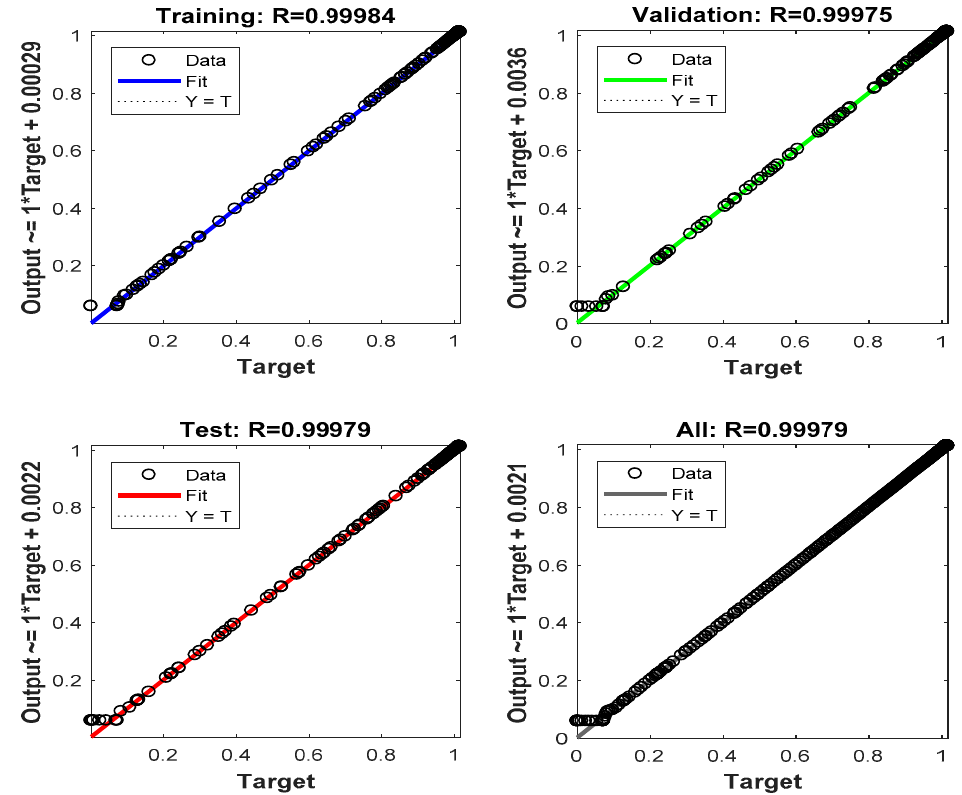
Figure 26. Results of fuzzy after NN optimization.